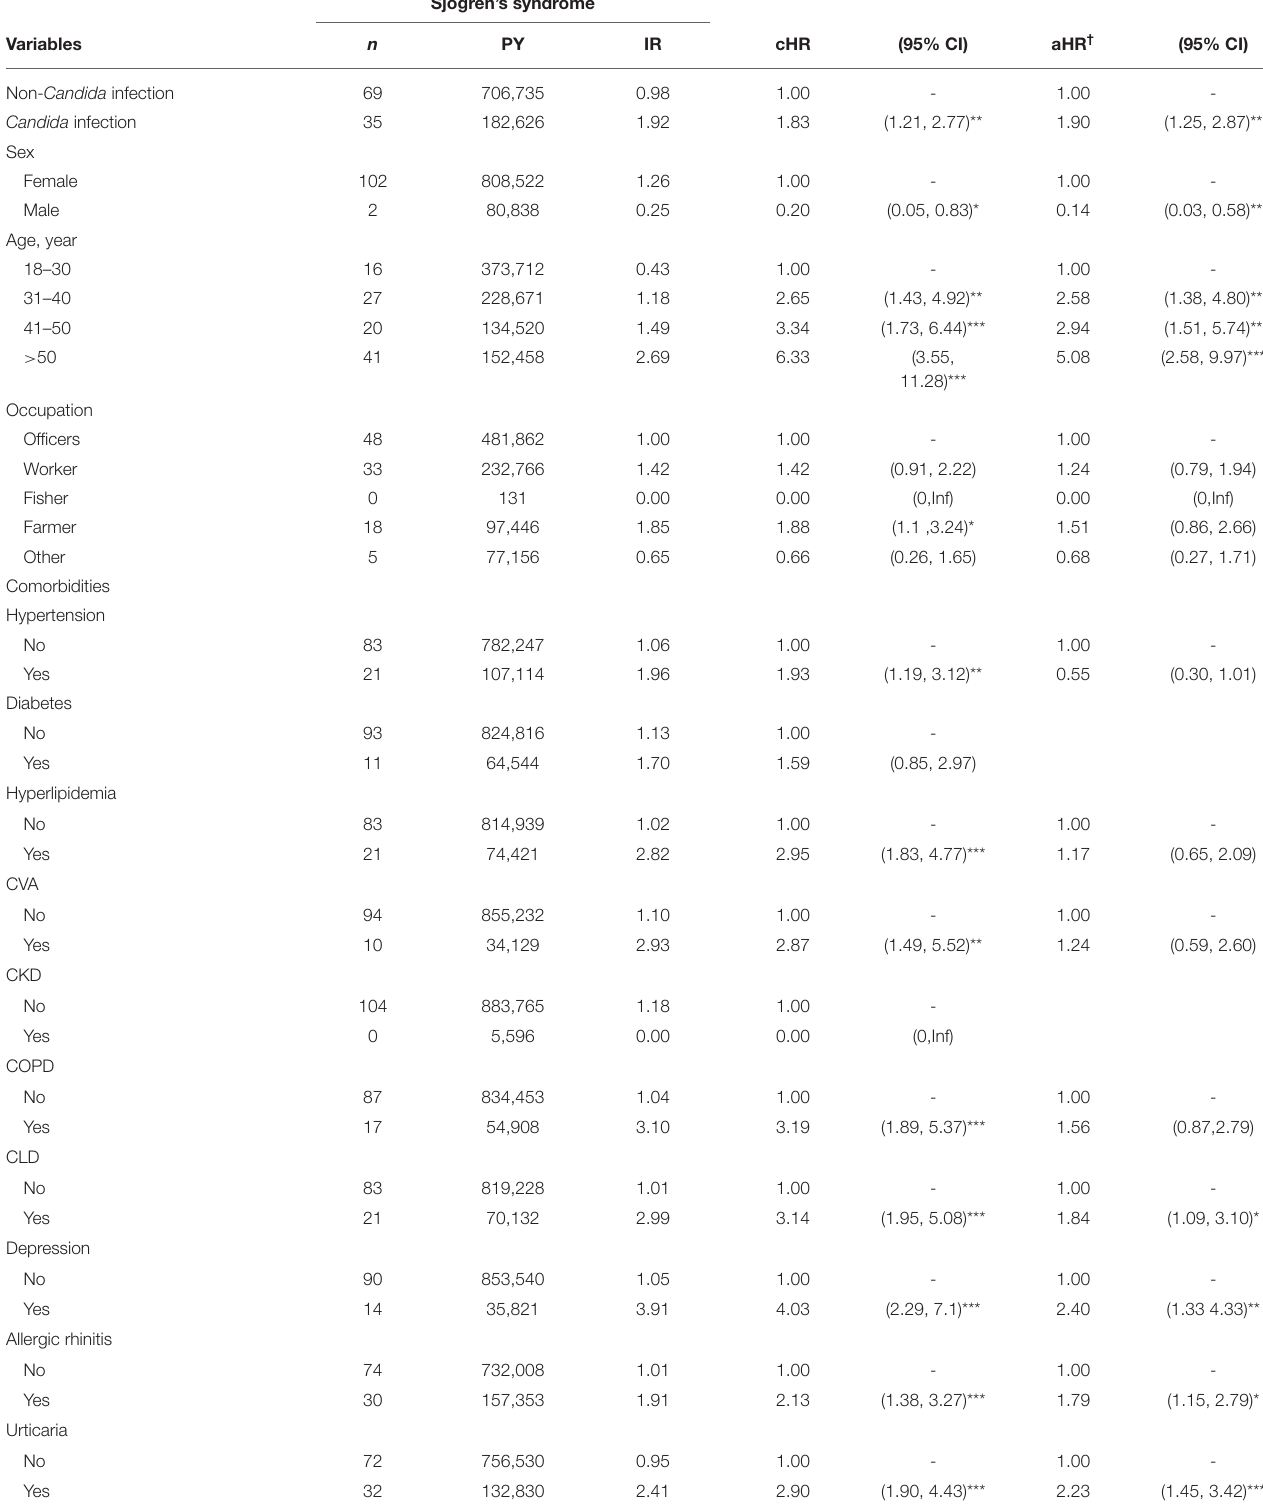
TABLE 2 | The incidence rate and hazard ratio of Sjögren’s